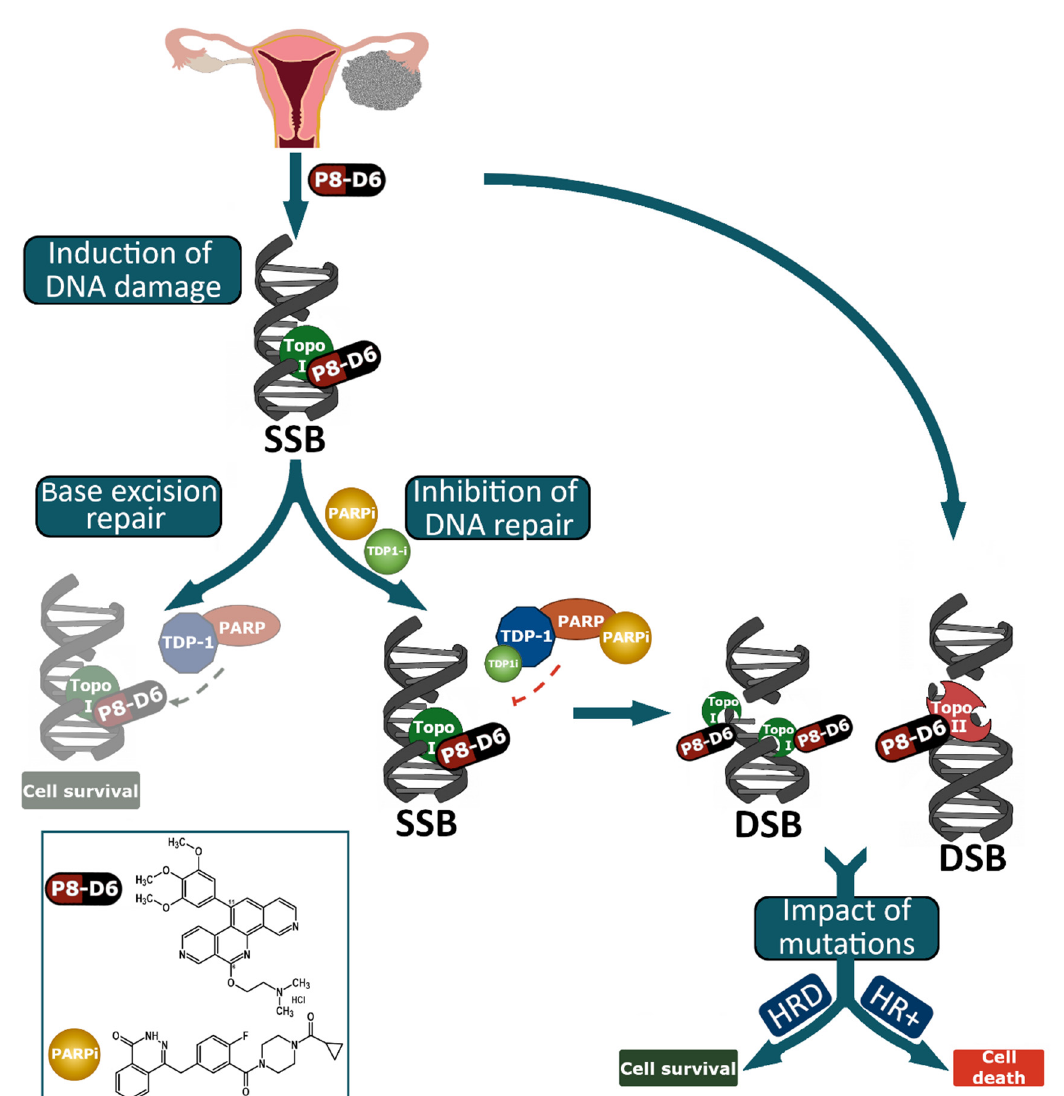
Figure 1. Mode of action of dual topoisomerase inhibition and PARP inhibition. The schematic representation shows the proposed targets of PARPi and topoisomerase inhibitors. PARP is involved in different DNA repair pathways, including BER and HR. Here, PARP contributes to the detection of lesions and the initialization of repair. Combining PARPi with P8-D6 causes an increase in genomic instability. P8-D6 stabilizes the topoisomerase I and II-DNA covalent complex, thereby leading to an increase of DNA damage in the form of SSBs and DSBs. By SSB repair, if DNA repair functions via TDP1 and PARP, the cell survives. Inhibition of PARP and/or TDP1 results in the accumulation of SSBs and DSBs, which can be repaired by HR. Moreover, the inhibition of Topo II generates DSB. If there is an HR deficiency, cells cannot be repaired via the HR pathway and go into induced apoptosis.